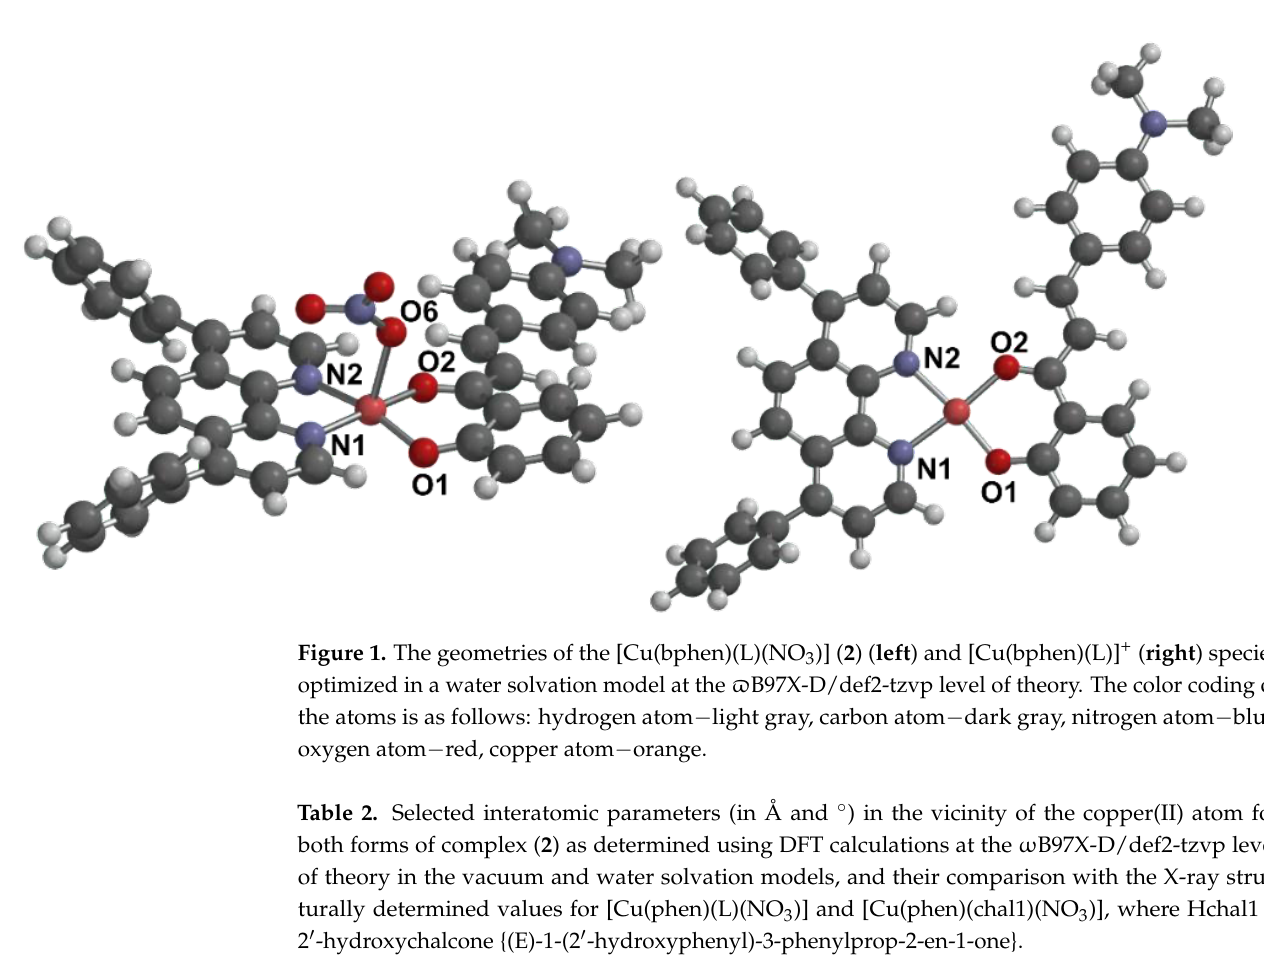
Figure 2. An overlay of the DFT optimized geometries of the [Cu(bphen)(L)(NO 3 )] ( 2 ) and [Cu(bphen)(L)] + species in the water solvation model through the N 2 O 2 donor atoms, showing the separation of the Cu(II) atoms of 0.142 Å . The color coding of the atoms is as follows: hydrogen